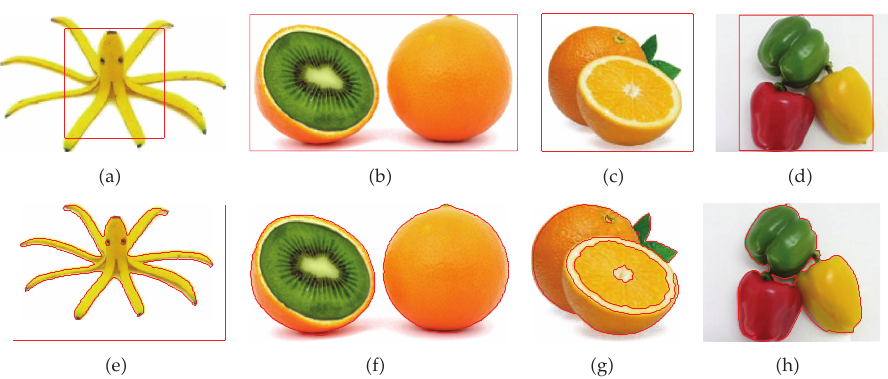
Figure 10: Results of the proposed model for several other color images. (cid:6) a (cid:7) – (cid:6) d (cid:7) The original images with the initial contours. (cid:6) e (cid:7) – (cid:6) h (cid:7) The original images with the final contours.